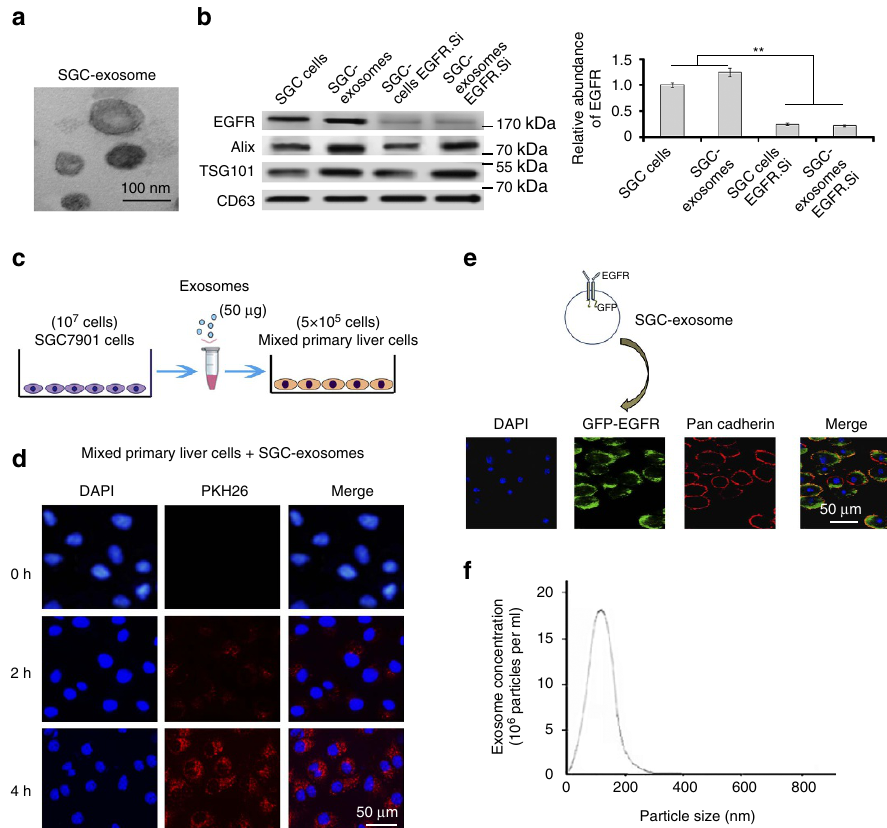
Figure 2 | SGC-exosomes transport EGFR into liver cells. ( a ) Electron microscope scanning of exosomes isolated from the medium of SGC7901 cells. ( b ) EGFR expression in both SGC exosomes and SGC7901 cells treated with EGFR siRNA. ( c ) Schematic description of the experimental design. The SGC exosomes were isolated and 50 m g exosomes were used to culture with 5 (cid:2) 10 5 primary liver cells. ( d ) Confocal microscopy image of the internalization of fluorescently labelled exosomes in mixed liver cells. Scale bars, 50 m m. ( e ) SGC-exosome-mediated EGFR is located in the membrane of mixed primary liver cells. Scale bars, 50 m m. ( f ) Nanoparticle Tracking Analysis (NTA) of isolated exosomes. The data represent the mean ± s.e.m. ** P o 0.01 (Student’s t